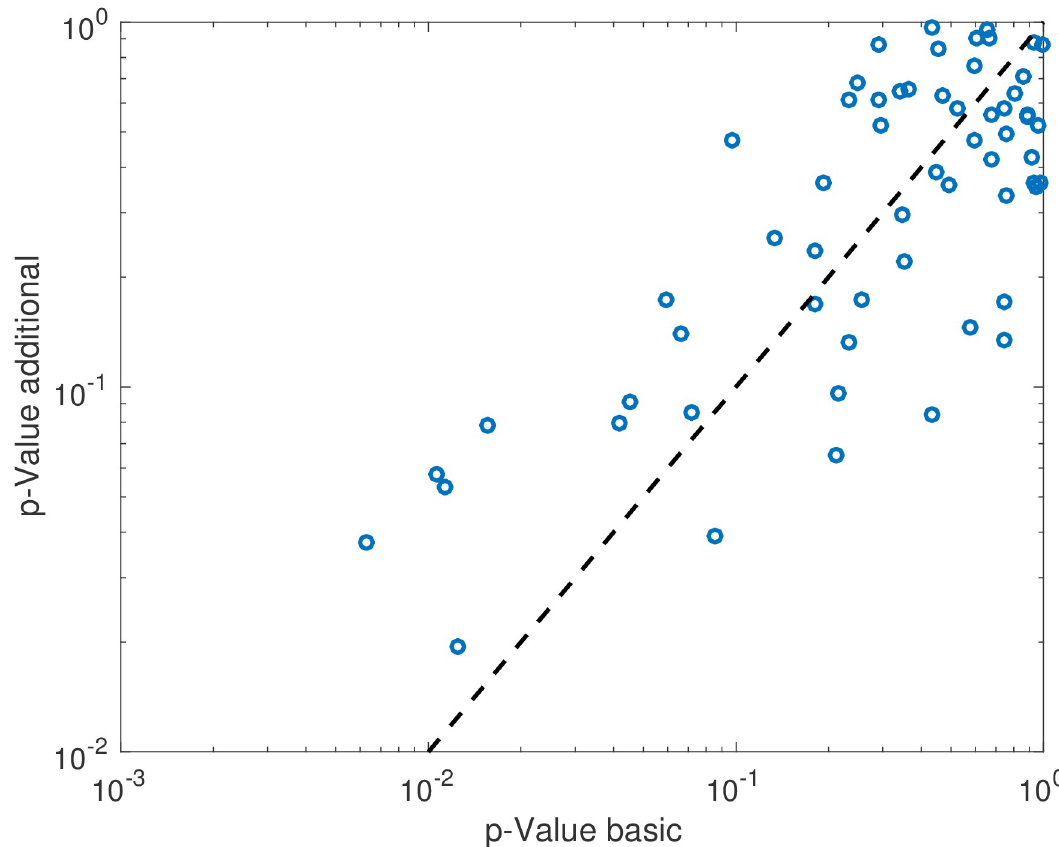
Fig 6. Raw p-values of metabolites after controlling for clinical variables. After controlling for aspirin, history of smoking, hypertension and hyperlipidemia, raw p-values correlated.